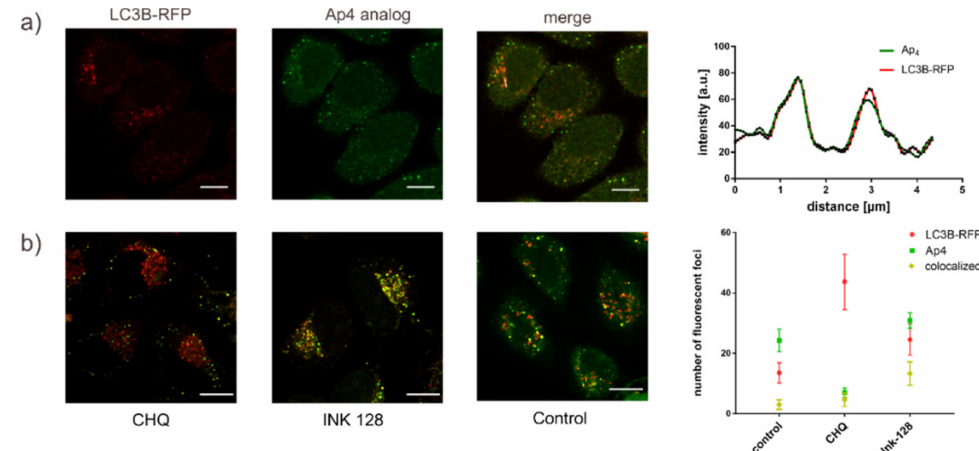
Figure 6. Colocalization of Ap4 hydrolysis and LC3B-RFP, and quantification of autophagosome– lysosome fusion with Ap4 hydrolysis. ( a ) HeLa cells were transfected with the autophagy sensor LC3B-RFP and cultured for 24 h (red). The cells were then treated with Ink-128, an autophagy inducer, for 4 h before electroporation with the Ap4 analog (green). Line profiles for the pixel intensities of the colocalized Ap4 and LC3B-RFP. Scale Bar: 10 µ m. ( b ) Cells were transfected with LC3B-RFP (red) and cultured for 24 h. Cells were then treated with Ink-128 (green), an autophagy inducer, or chloroquine (green), an autophagy inhibitor, for 4 h before the introduction of the Ap4 analog. Quantification of intensity spots and colocalization (yellow) was done using the ComDet plugin of Fiji. Data represent the average number of fluorescent spots per cell. Error bars mark ± SD for each condition, (N ≥ 15). Statistical significance was determined by Tukey’s multiple comparisons test. Scale bar: 10 µ